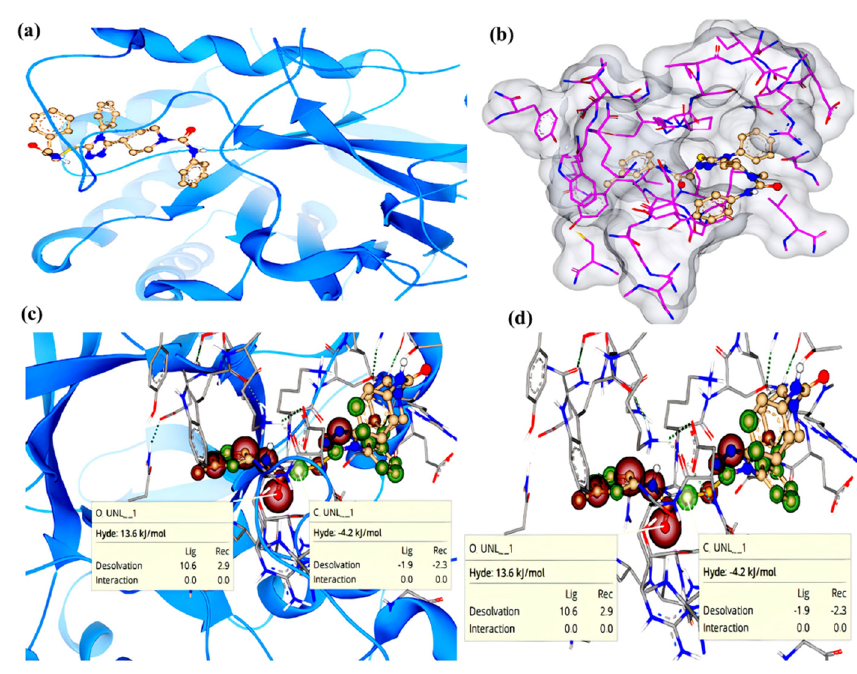
Figure 7. SeeSAR analysis of potent derivative 7f in the pocket of AKR1B10. ( a , b ) Ligand in active pocket of targeted protein. ( c , d ) Docked conformations with coronas. Unfavorable aspects are indicated by red coronas, while positive contributions are indicated by green coronas, and colorless coronas indicate no structural component contribution.